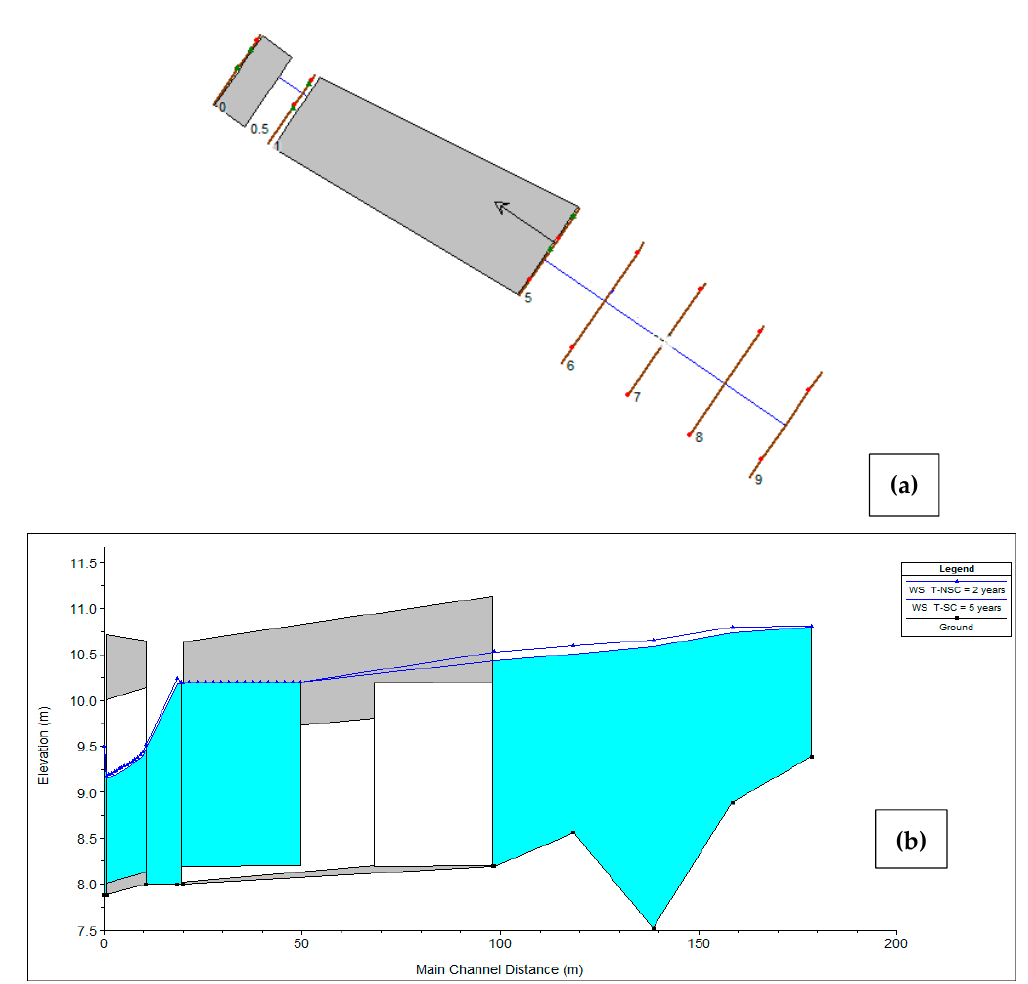
Figure 9. Hydraulic modeling with HEC–RAS: ( a ) Plan view; ( b ) longitudinal profile. WS indicates the water surface level.